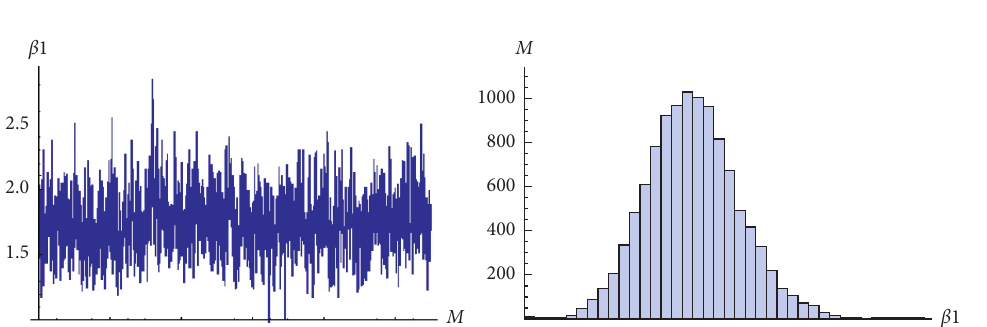
Figure 2: Simulation MCMC generated number/histogram of the parameter α